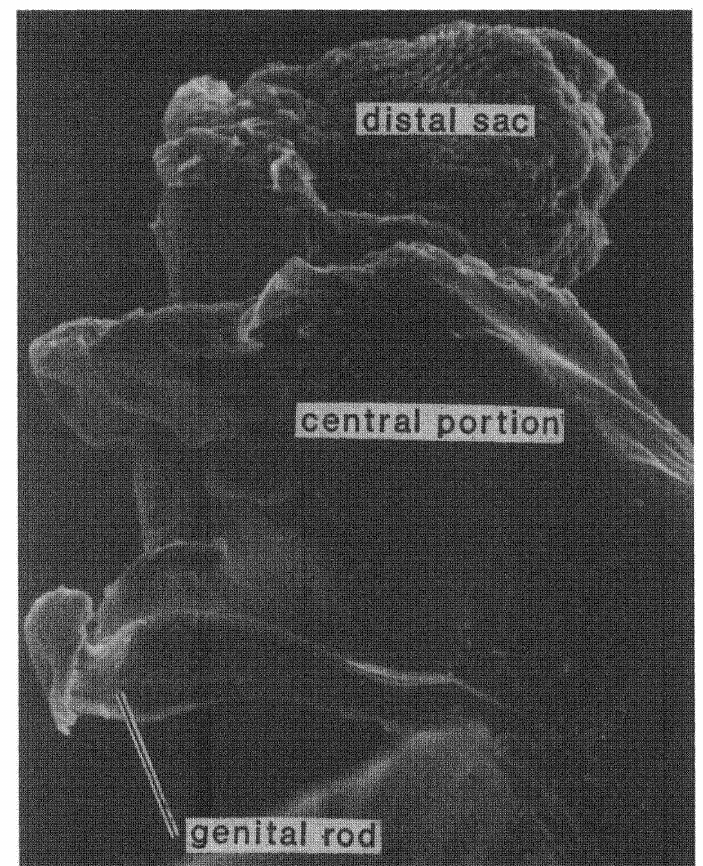
Fig. 4. Scanning electron micrograph of the distiphallus of a male Ceratitis cap- titata. deflated. Maximum inflation increased the diameter an estimated 50-100% over that when the sac was minimally inflated. Inflation of the distal sac caused it to expand mostly in the ven- tral direction (away from the central portion of the distiphallus) rather than basally or distally. Inflation of the distal sac was not synchronous or coordinated in any obvious way with that of the basal sac. The two sacs are apparently hydraulically independent. When pricked with a pin, the distal sac of a living male